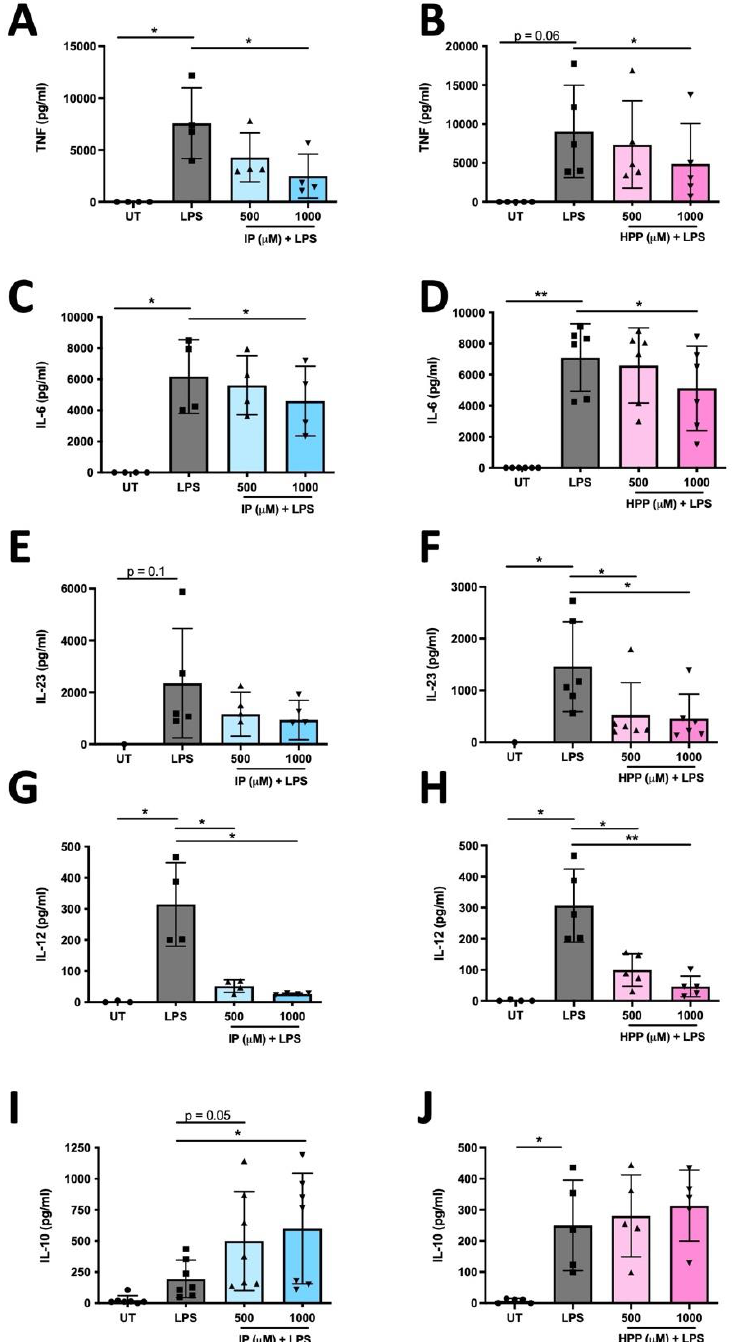
Figure 3. HPP and IP reduce the production of pro-inflammatory cytokines in LPS-stimulated human DC. Primary human DC were left untreated (UT) or incubated with IP ( A , C , E , G , I ) or HPP ( B , D , F , H , J ) (500–1000 µ M) for 6 h prior to stimulation with LPS (100 ng/mL) for 24 h. Cell supernatants were assessed for TNF, IL-6, IL-23, IL-12p70, and IL-10 secretion by ELISA. Pooled data depict mean (±SEM) cytokine concentrations for four to seven healthy donors (means of three technical replicates per donor). Repeated measures one-way ANOVA, with Dunnett’s multiple comparisons post hoc test, was used to determine statistical significance, by comparing means of treatment groups against the mean of the control group (** p < 0.01, * p < 0.05).